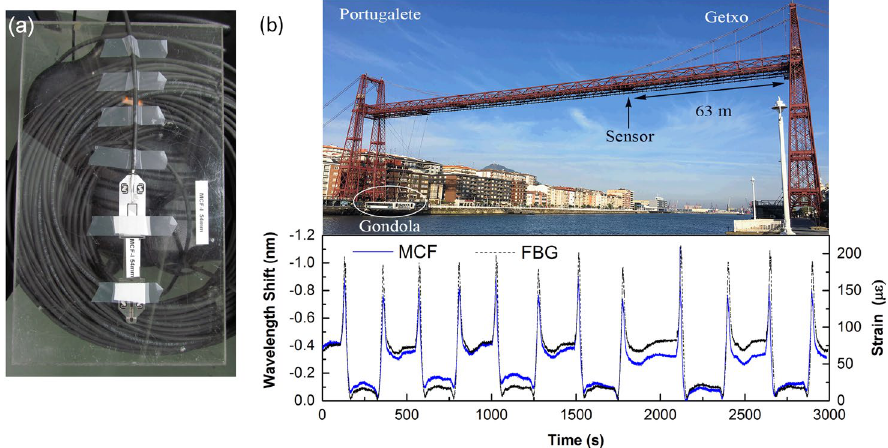
Figure 5. ( a ) Photograph of a packaged MCF sensor. The black cable is the 100 m long patchcord. ( b ) Photograph of the Vizcaya Bridge highlighting the position of the sensor and the hanging gondola. The bottom graph shows the shift of the interference pattern of our MCF sensor and the strain measured by an FBG sensor at the same point of the crossbeam of the bridge while the gondola moved from Portugalete to Getxo and